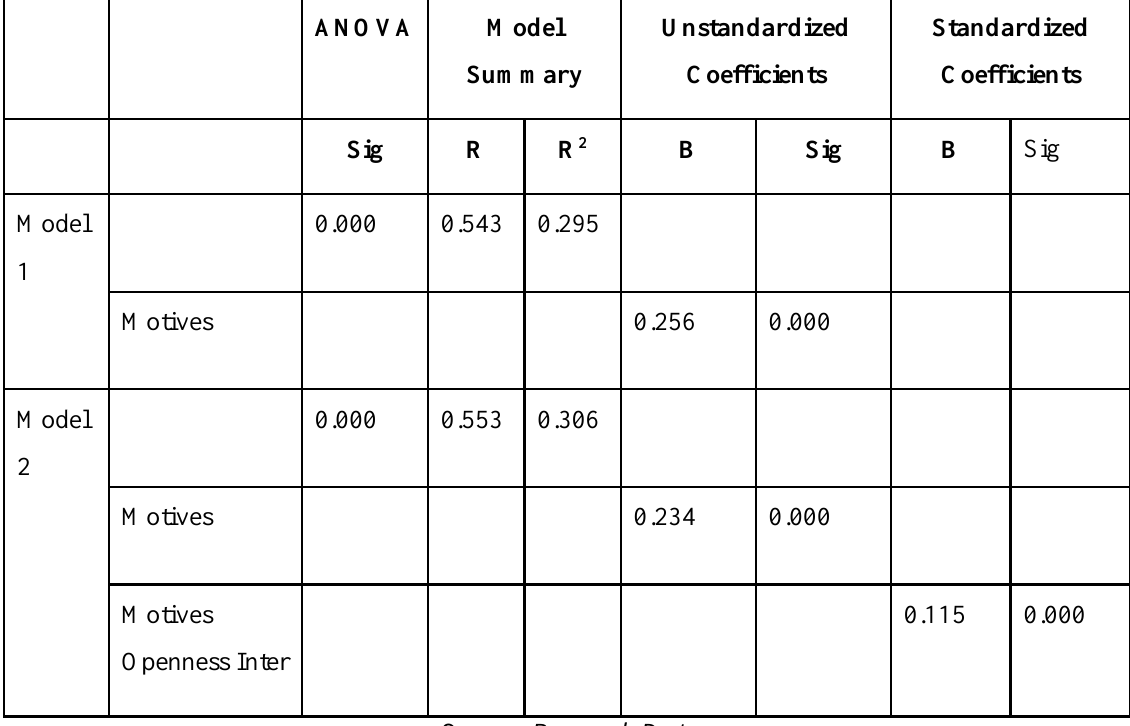
Table 2: Summary of Moderation (Openness to Experience)